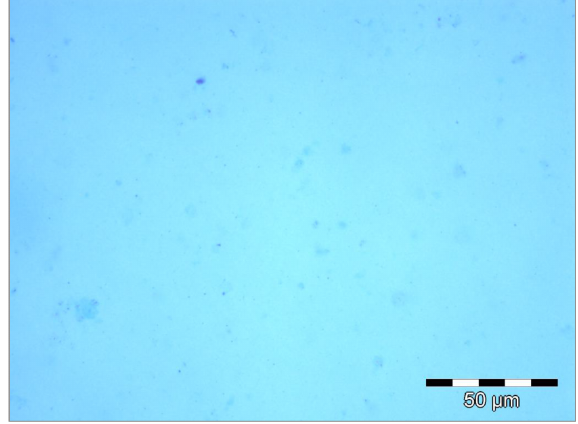
Figure 20. Microscopy image of TEPs in TSP aerosol particles sampled at the CVAO between 29 and 30 September with a flow rate of 8Lmin − 1